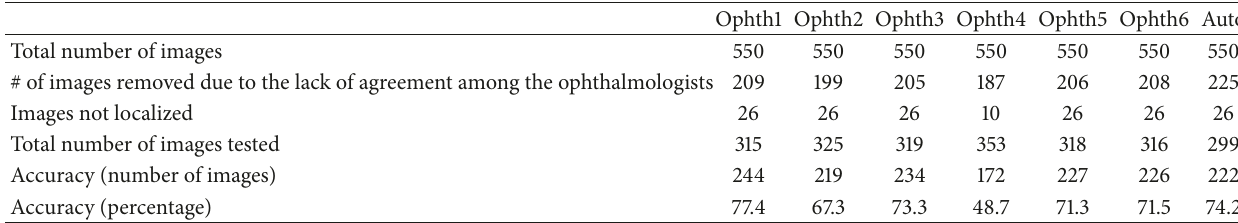
Table 15: Results for all three datasets combined together.